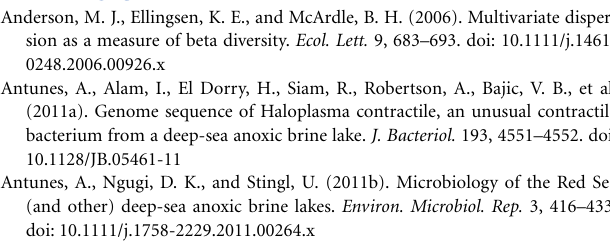
observation. The ordination of observations is represented by either blue triangles(cluster1)orredsquares(cluster2).Whiletheblackcrossesrepresent theordinationofvariables,whichisdeducedfromtheweightedaverageoftheir respective observations. An ellipse around the centroid of each cluster depicts 95% confidence in the assignment of observations to the